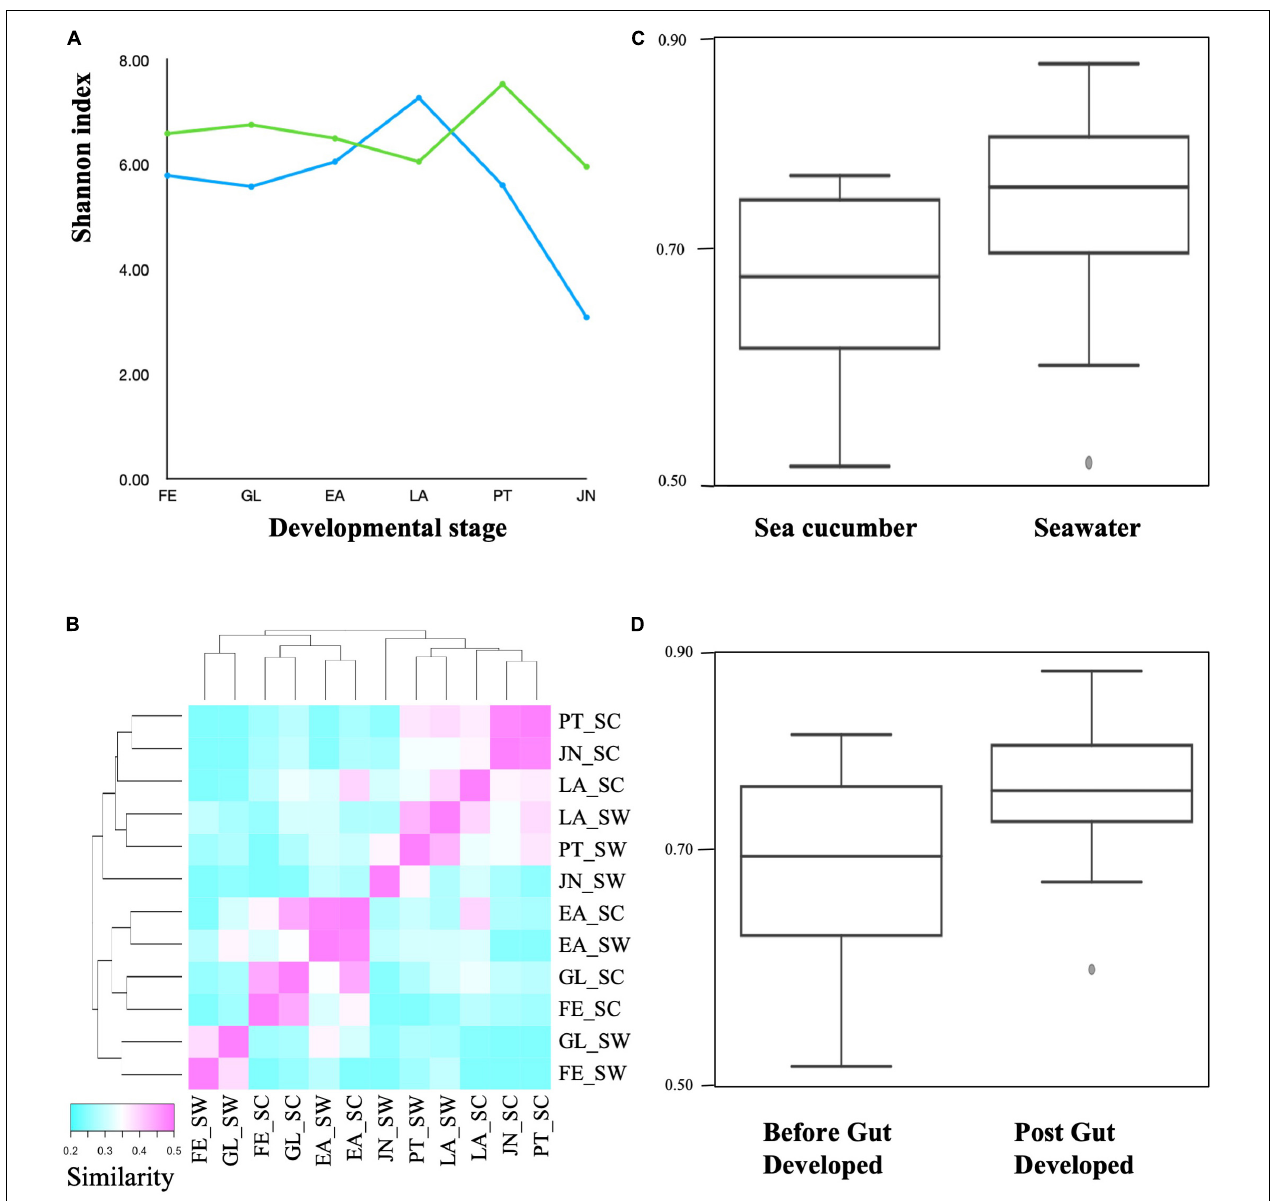
FIGURE 2 | Alpha and beta diversity among sea cucumber and seawater samples. (A) Shannon index. Green, sea cucumber samples; blue, seawater samples. (B) Heatmap based on unweighted UniFrac distance ( p < 0.05, q < 0.05). Scale represent similarity within samples. FESC, Fertilized egg; GLSC, Gastrula; EASC, Early auricularia; LASC, Late auricularia; PTSC, Pentactula; JNSC, Juvenile; FESW, Fertilized egg rearing seawater; GLSW, Gastrula rearing seawater; EASW, Early auricularia rearing seawater; LASW, Late auricularia rearing seawater; PTSW, Pentactula rearing seawater; JNSW, Juvenile rearing seawater. (C) Unweighted Unifrac distance plot between sea cucumber and seawater ( p < 0.05, q < 0.05). (D) Unweighted Unifrac distance plot between samples before and post-gut developed ( p < 0.05, q <